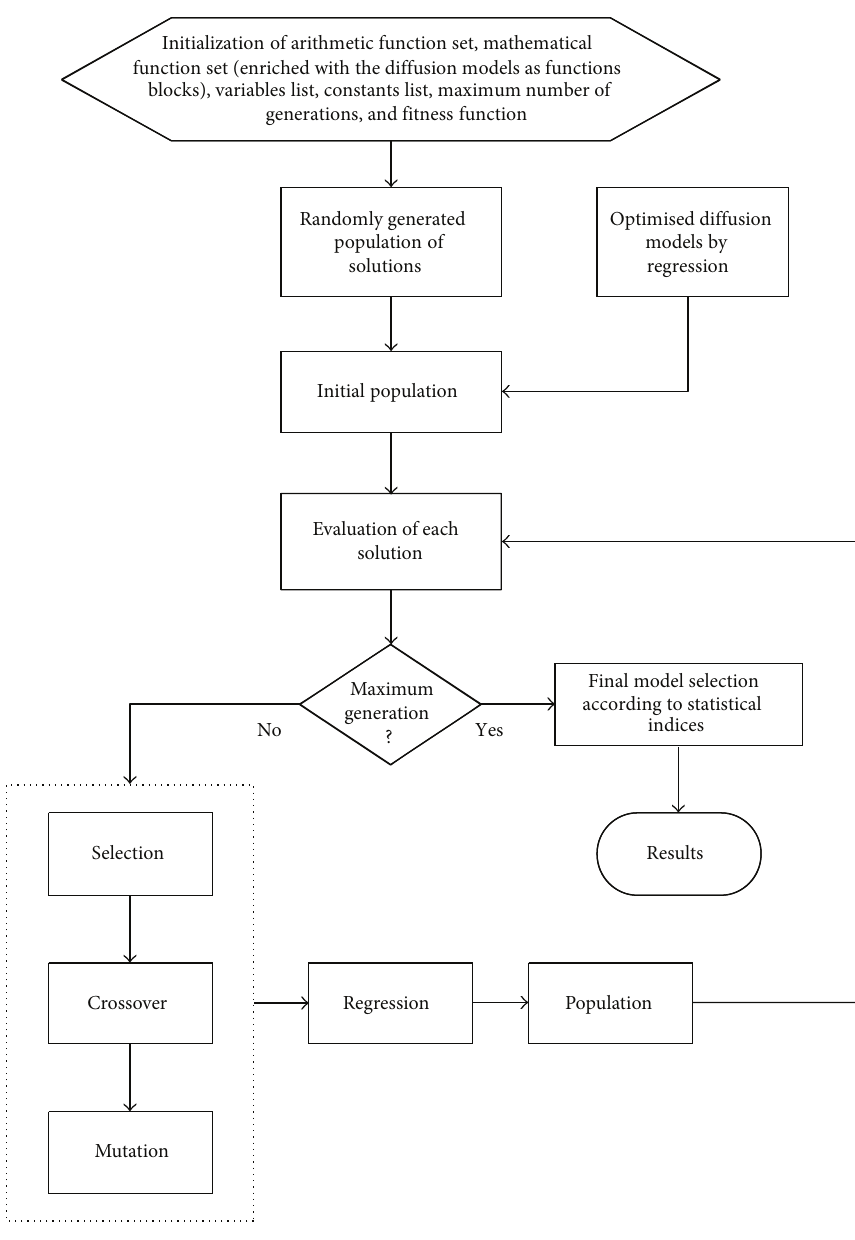
Figure 1: Flowchart of the modified